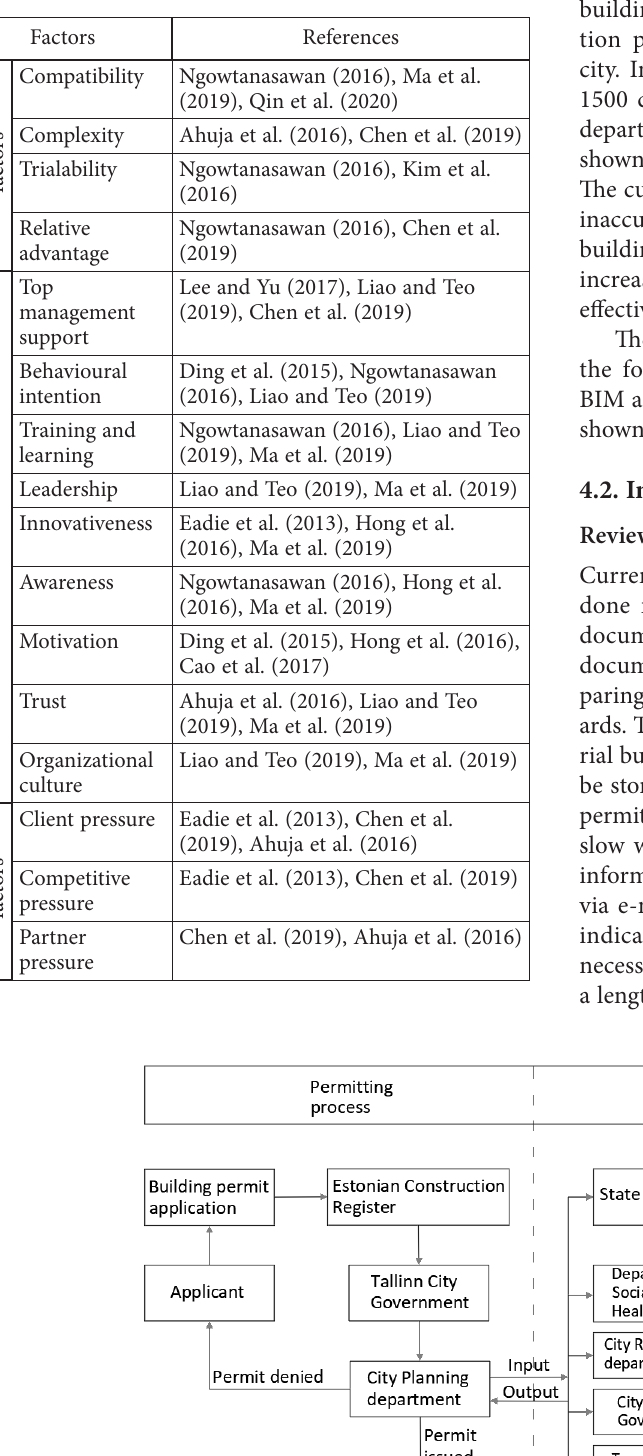
Table 3. Factors affecting BIM adoption